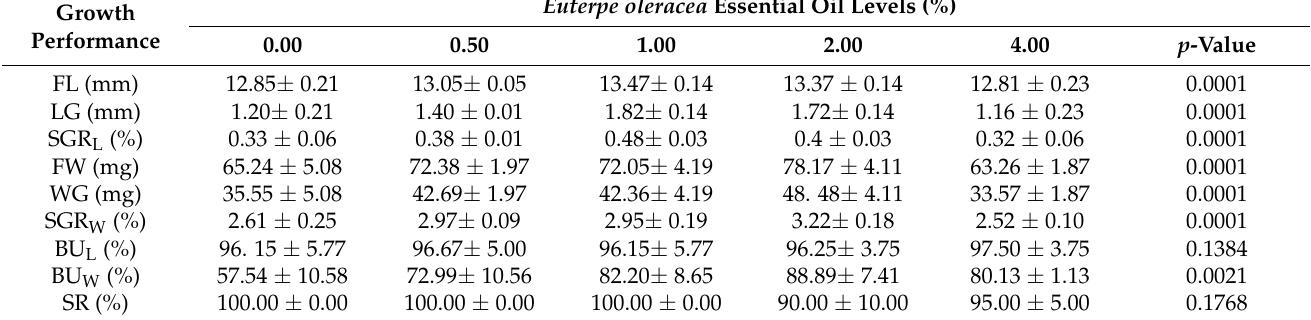
Table 2. Growth performance (mean ± standard deviation) of P. scalare post-larvae fed diets contain- ing levels of Euterpe oleracea essential oil.